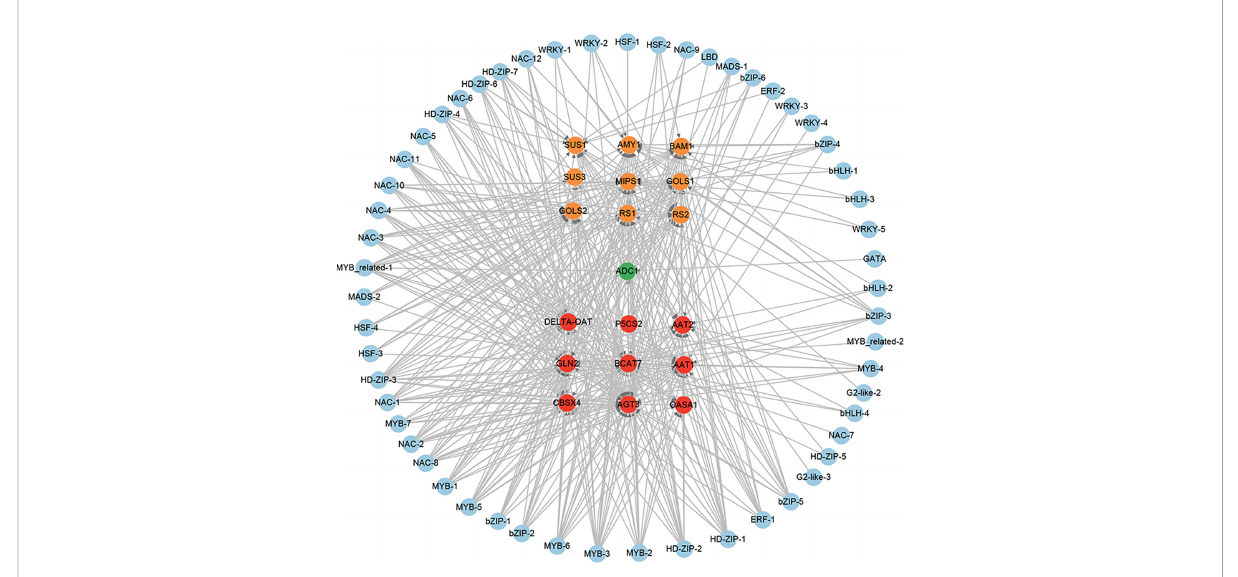
FIGURE 13 The regulatory network of osmotic adjustment genes from the core drought-resistant genes in XZSN. Genes labeled by yellow, green, and red circles represent the soluble sugar, amino acid, and polyamine biosynthesis genes,